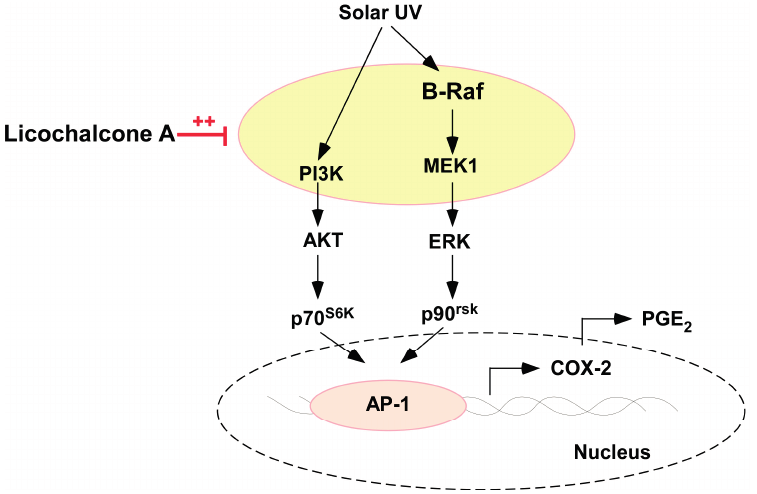
Figure 6. Hypothetical model for the inhibitory mechanism of LicoA against sUV-induced COX-2 expression. Red line, ++, dotted